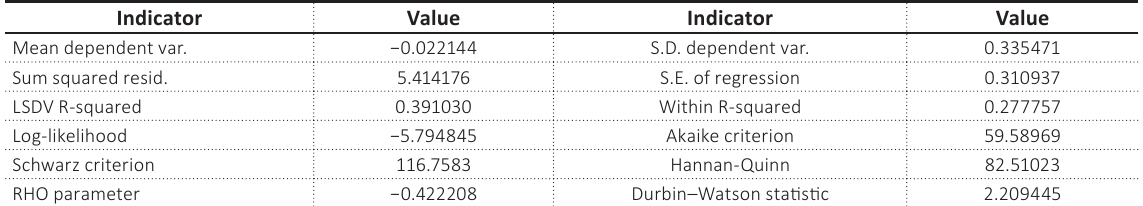
Source: Calculated via Gretl software